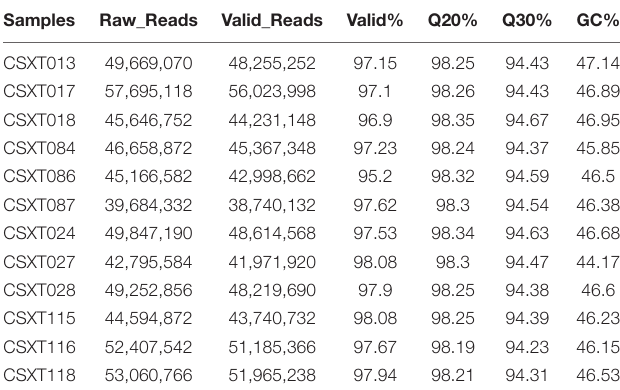
TABLE 1 | Transcriptome sequencing